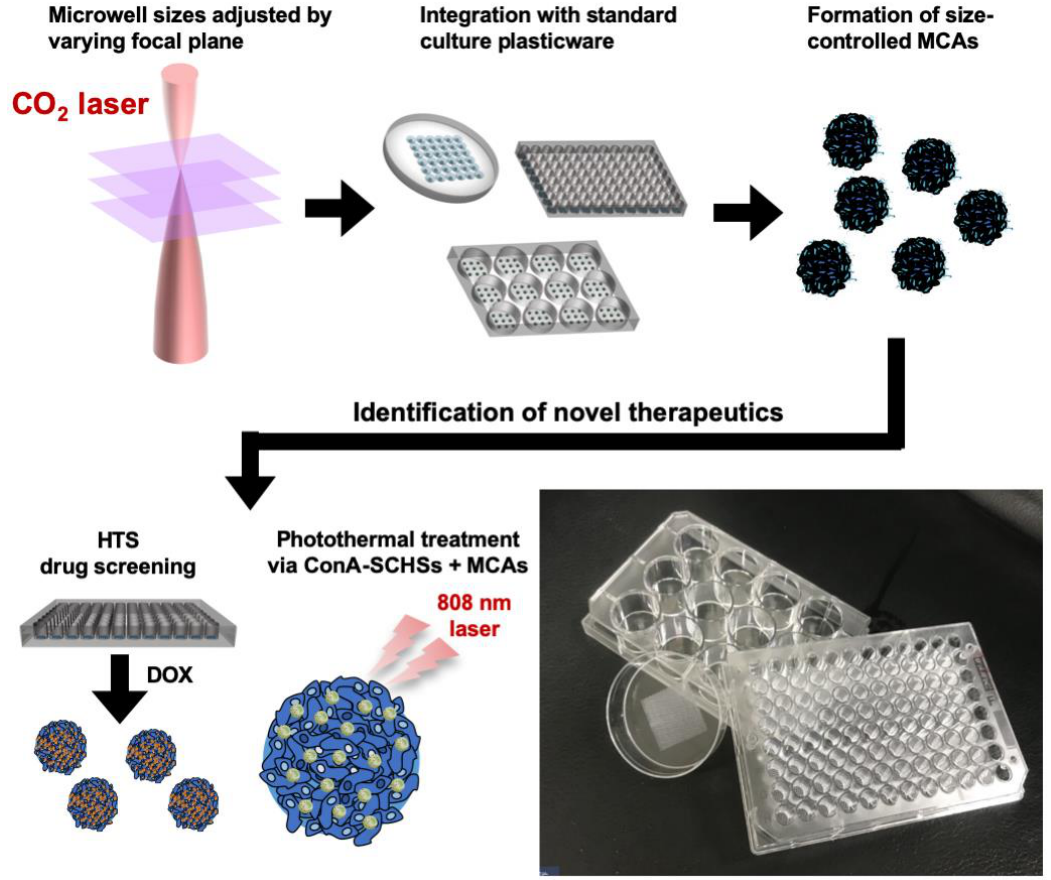
Figure 1. Schematic illustrations and an image of the rapid laser ablation of microwells